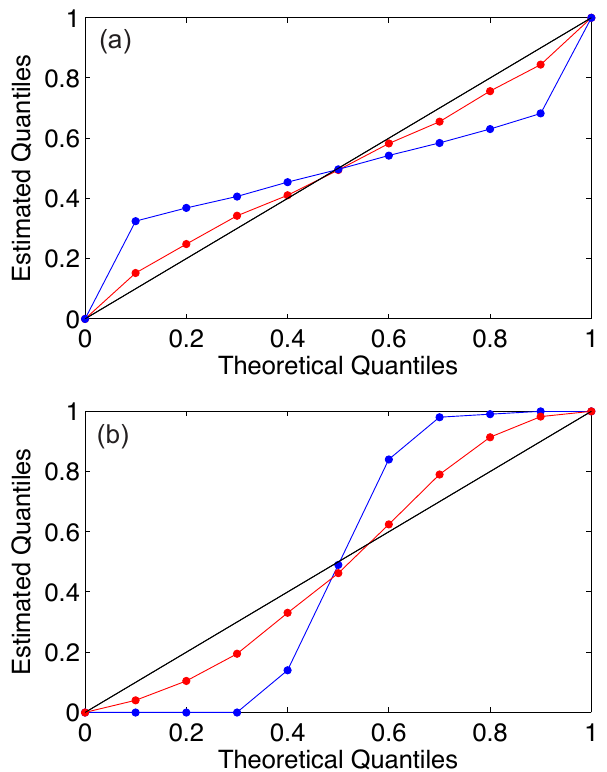
Fig. 1. Quantile–quantile (Q–Q) plots of a hierarchical Bayesian inversion (red) and a non-hierarchical Bayesian inversion (blue) in which a priori emissions uncertainties used in the inversion were (a) smaller than the true uncertainty (over-confident) and (b) larger than the true uncertainty